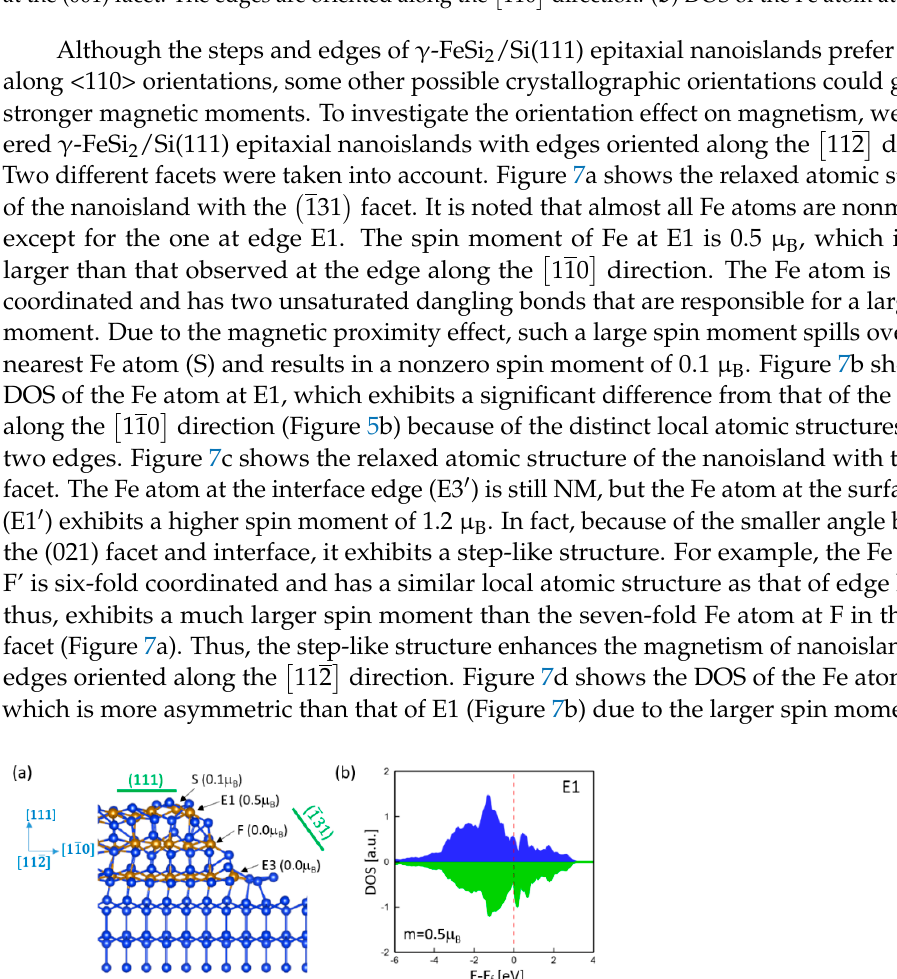
(cid:2) (cid:3) 112 direction. DOS of Fe atom at